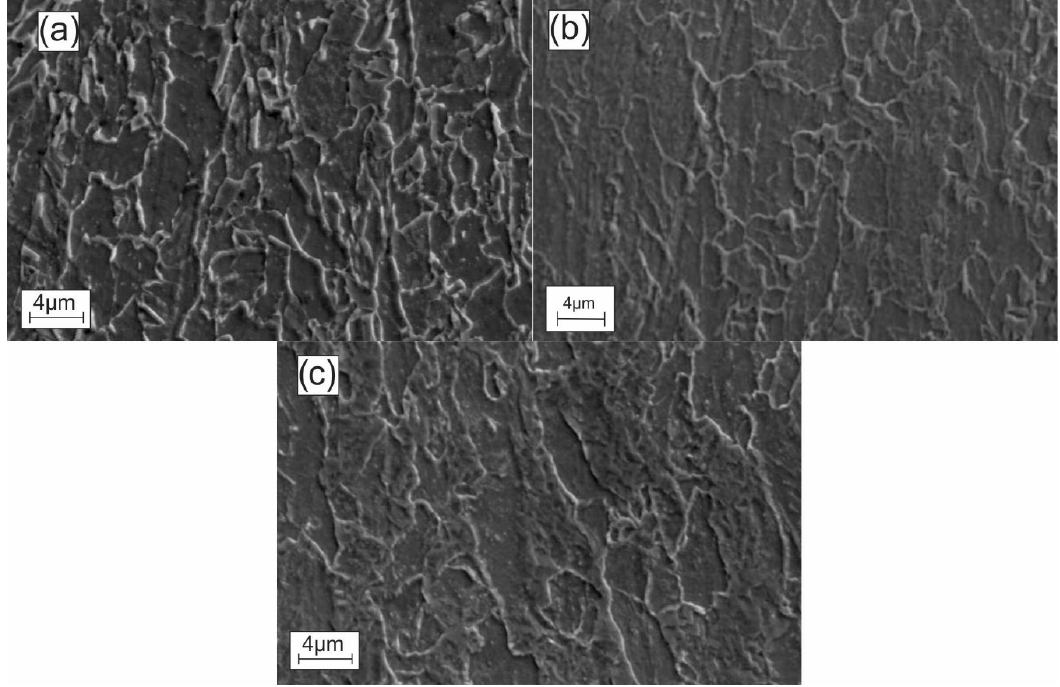
Figure 5. X-70 steel microstructures; ( a ) as-received, ( b ) treated at 600 °C, 30 min. ( c ) Treated at 600 °C, 1 h. Table 5. Acicular ferrite and upper bainite volume fraction of the microalloyed steel in the as-received condition and heat treated.